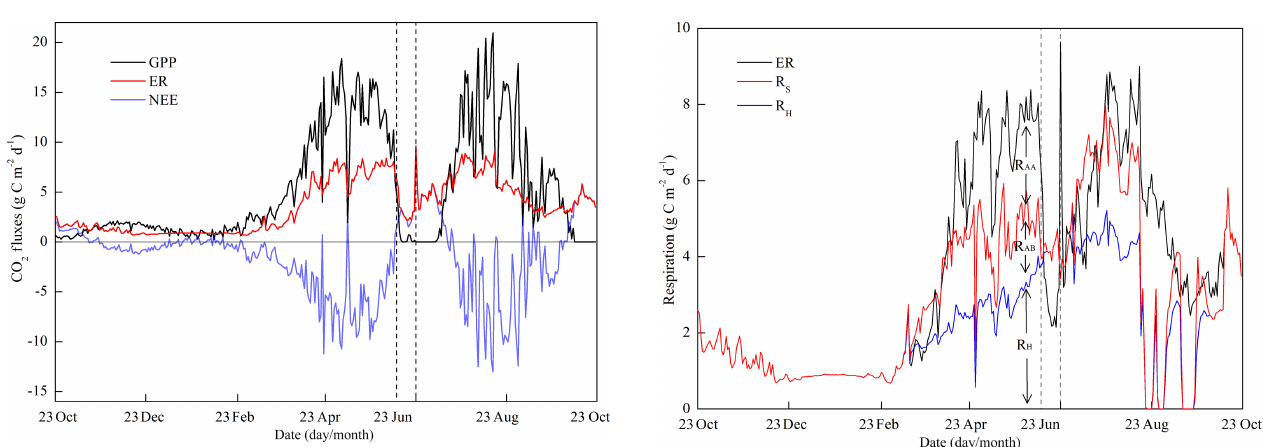
Figure 10. Seasonal variations in the components of ecosystem res- piration (ER), total soil respiration ( R S ) and soil heterotrophic res- piration ( R H ). The difference between ER and R S denotes above- ground autotrophic respiration ( R AA ), and the difference between R S and R H denotes below-ground autotrophic respiration ( R AB